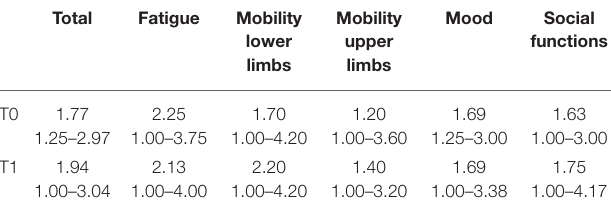
Lower scores indicate a higher HRQoL. Specifically, the number reported in the upper line of each cell reports the median and the numbers in the lower line report parameter range across all 28